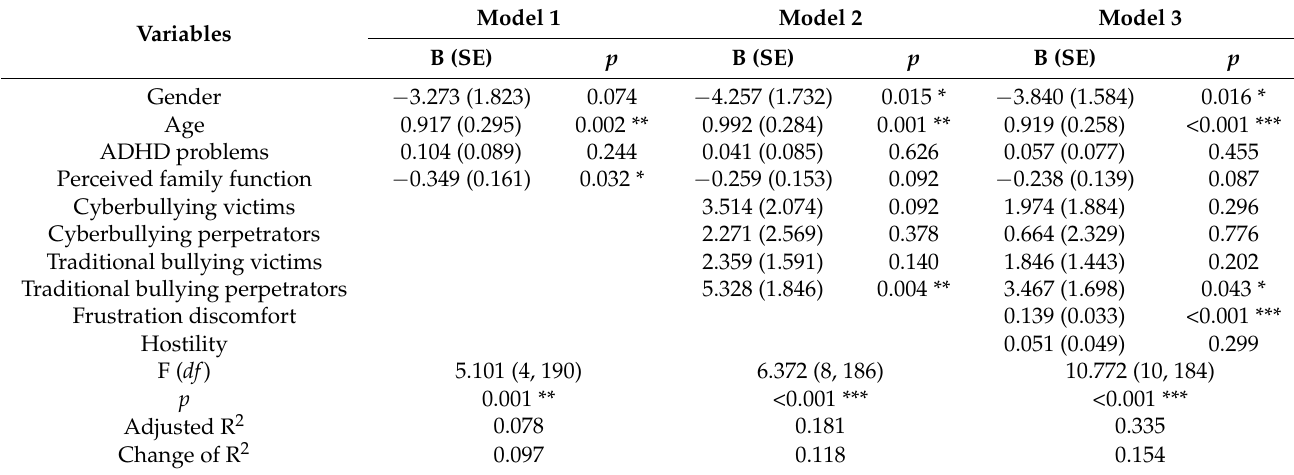
Table 2. Factors related to self-reported depressive symptoms: multiple regression analyses ( N = 195).